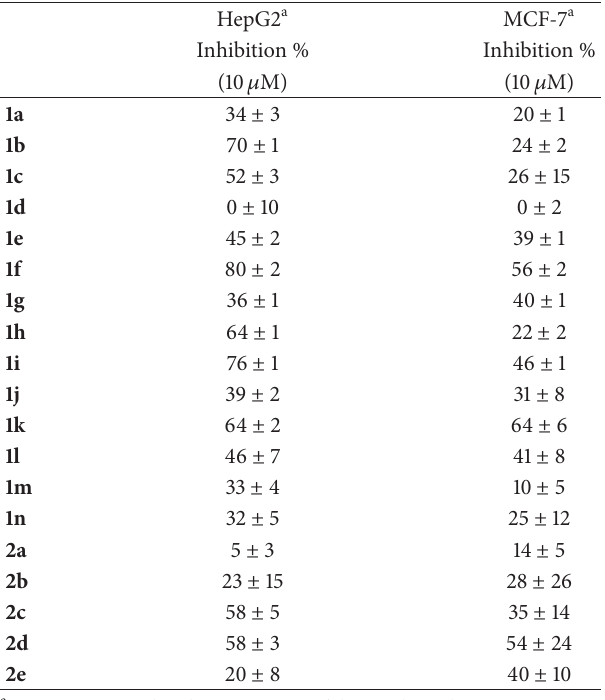
Table 2: Antiproliferative activity (% inhibition, MTT assay) of the target compounds 1a–n and 2a–e over HepG2 and MCF-7 cells.